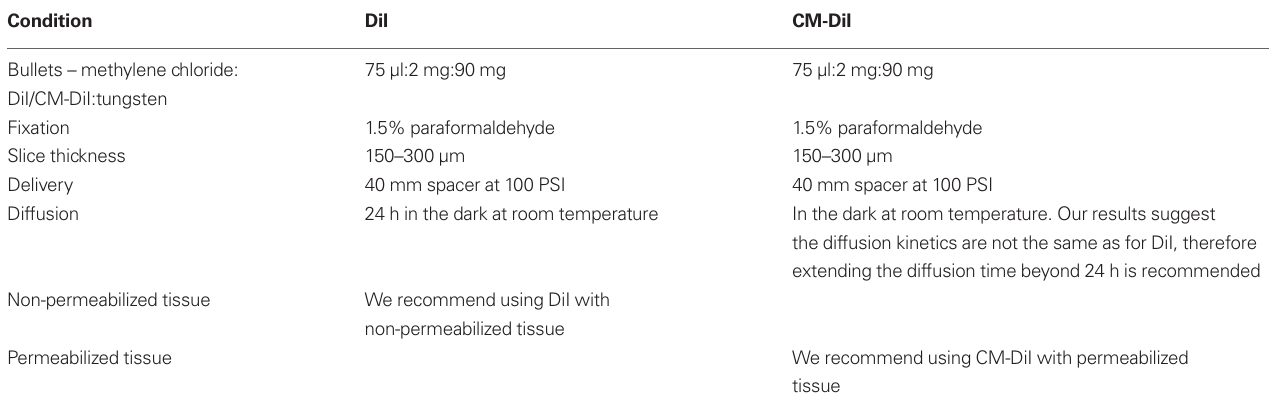
Table 2 | Summary of optimal DiOlistic protocol conditions for both Dii and CM-Dii. Condition